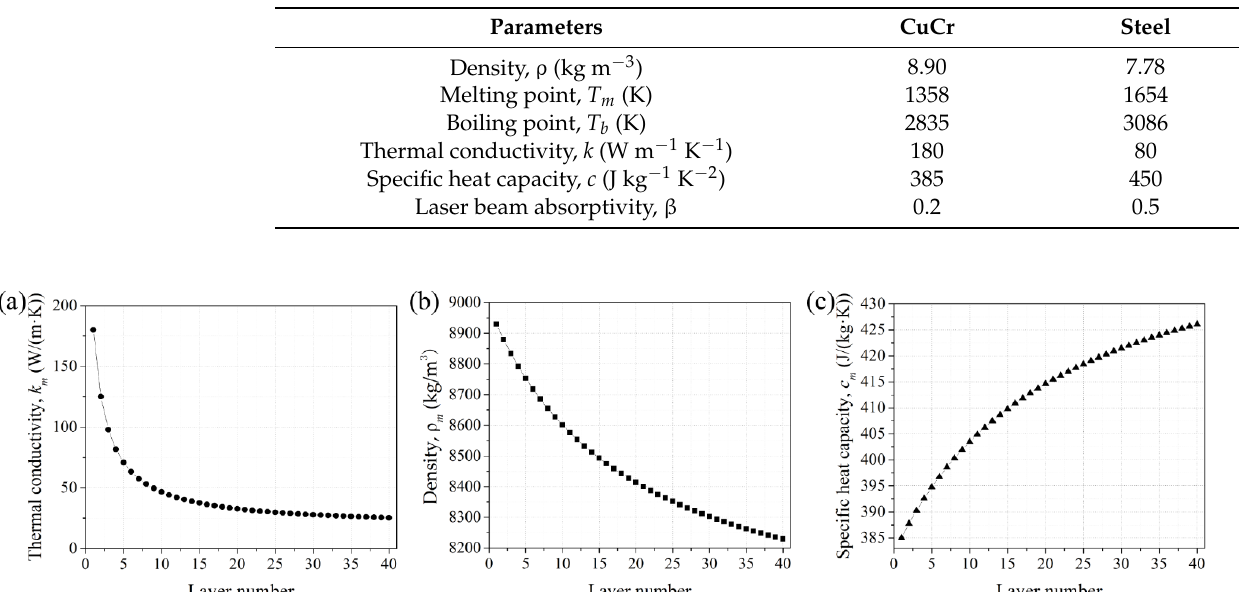
Table 1. Thermophysical properties of CuCr and steel for the calculation [43–47].